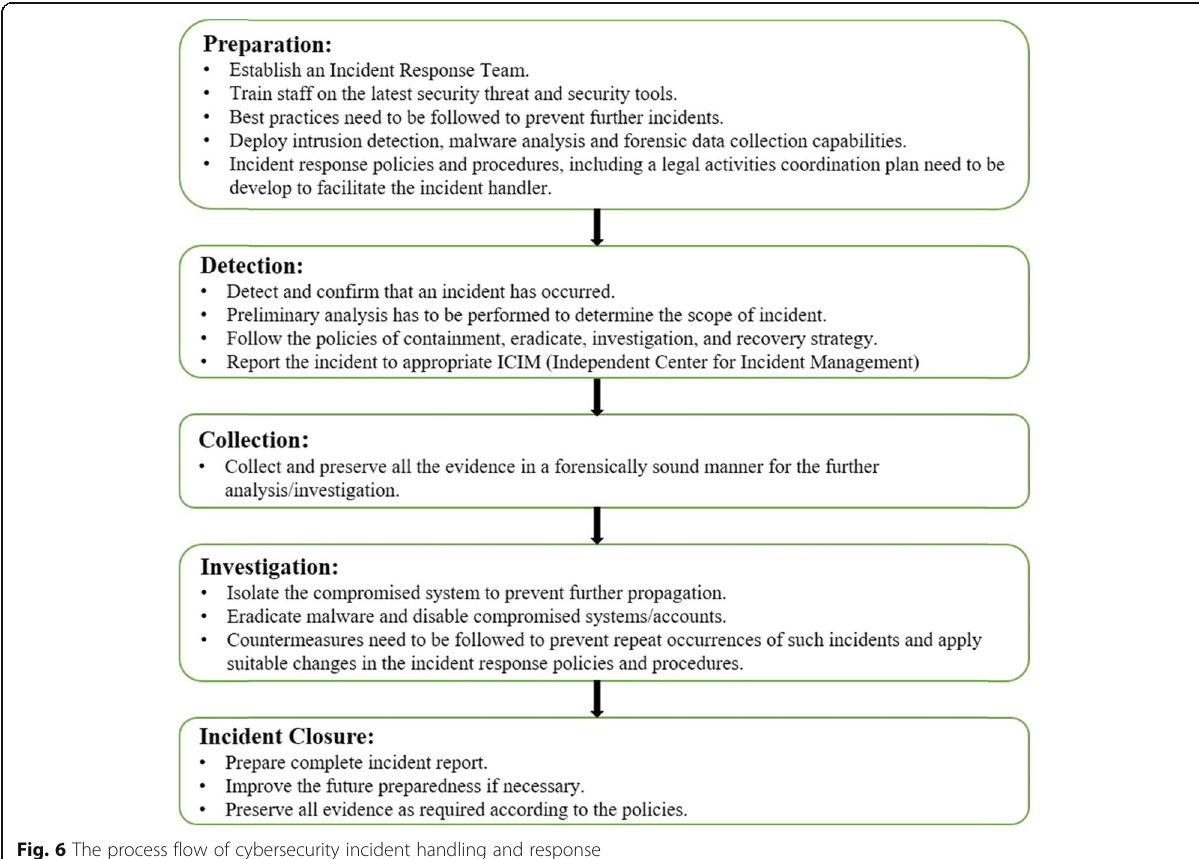
Fig. 6 The process flow of cybersecurity incident handling and